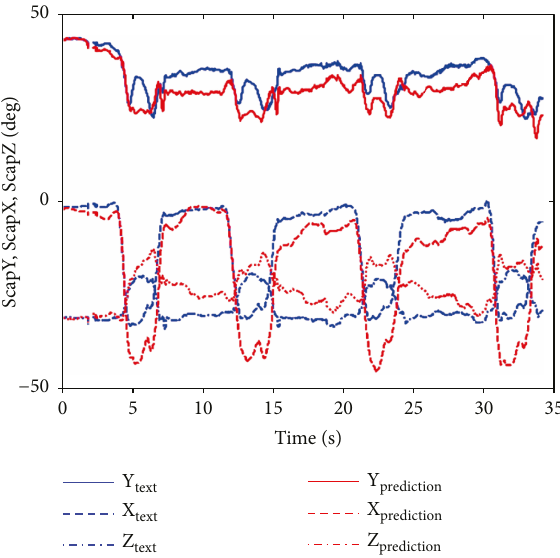
Figure 14: The movement of the scapula with respect to the thorax (ABD).